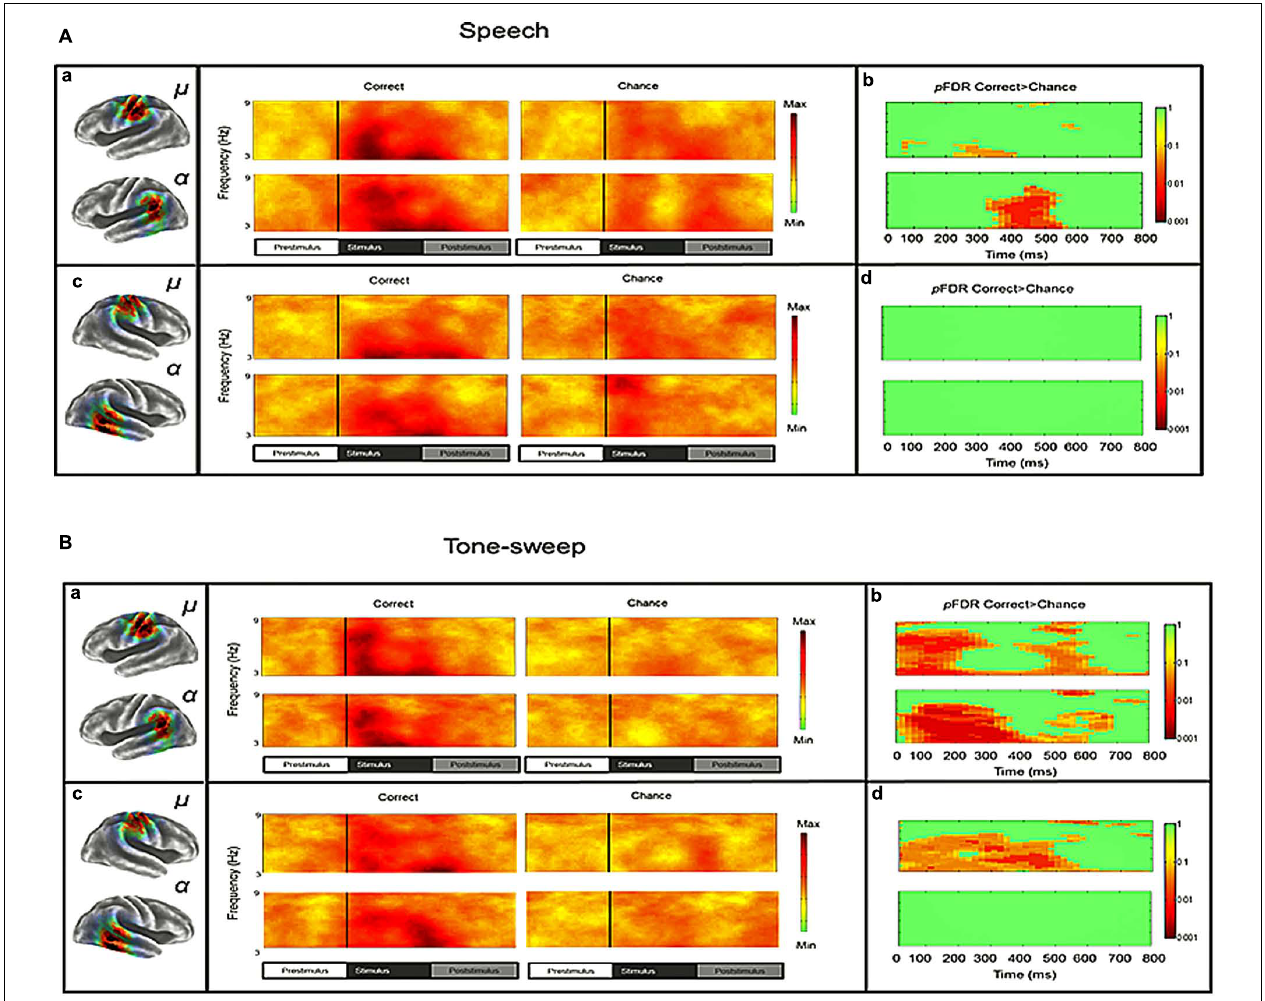
FIGURE 6 | Mean ITCS for correct and chance trials as a function of stimulus type and performance level for left and right sensorimotor and temporal clusters in the syllable discrimination condition. (A) Mean ITC values for left and right clusters in the syllable discrimination condition with significant differences between correct and